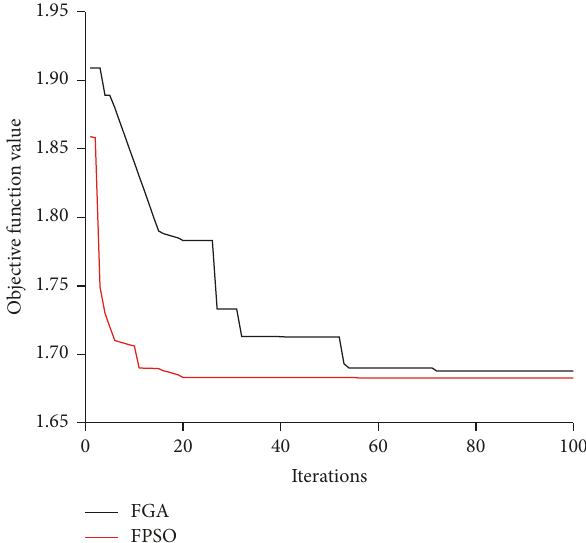
Figure 14: Convergence situation of the two optimization algo- rithms.